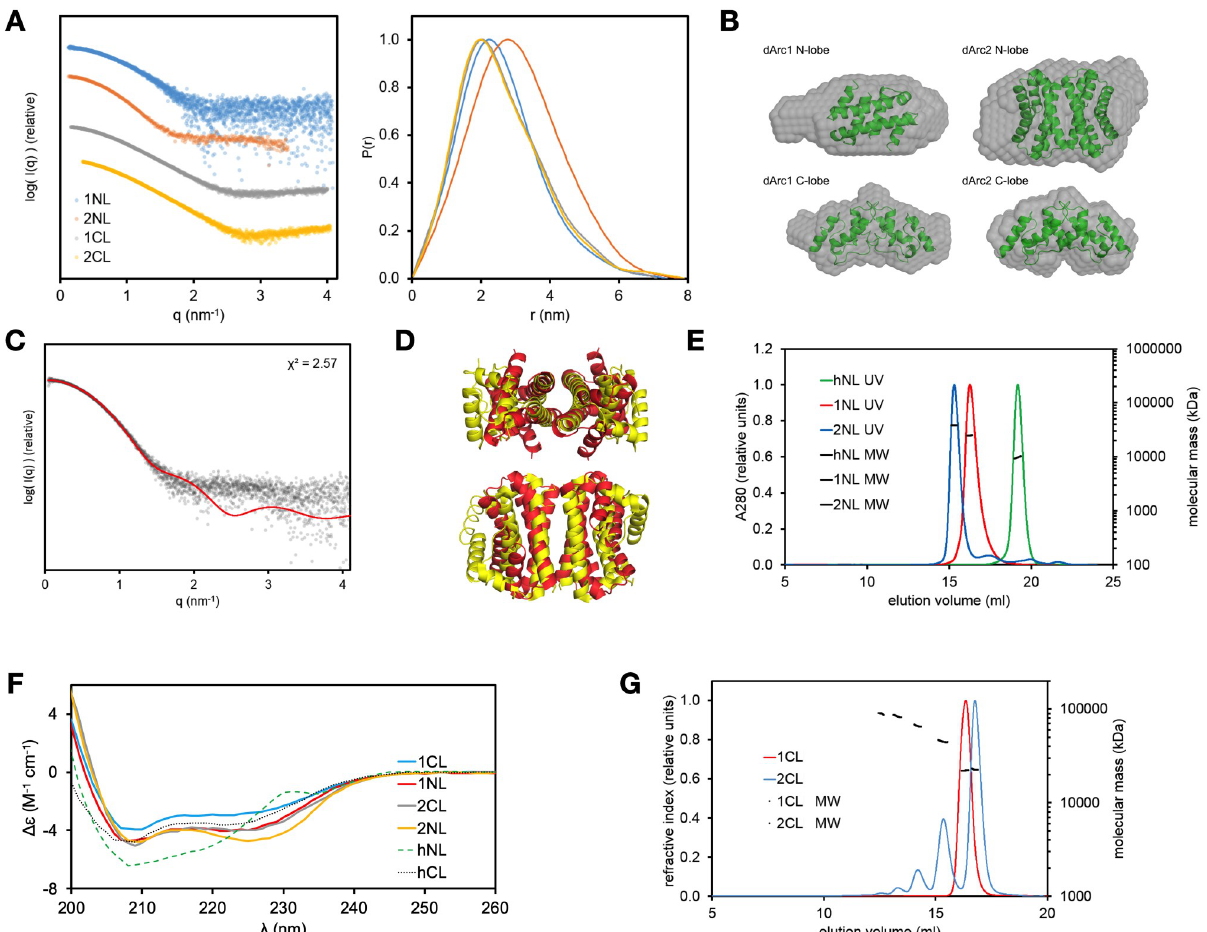
Fig 9. Solution structures of dArc lobe domains. (A) SAXS data for dArc lobes in solution (left) and distance distribution plots (right). (B) Ab initio models (grey spheres) of dArc lobes. The models are superimposed with the following structures (shown as cartoons): dArc2-NL dimer (overlaid on dArc1-NL), dArc1-CL dimer (on dArc1-CL), a dimer of dArc2-NL dimers (on dArc2-NL), and dArc2-CL dimer (on dArc2-CL). (C) Fit of the SAXS data for dArc2-NL (dots) with the possible tetramer of dArc2-NL seen in panel (D). (D) Tetrameric assembly of the West Nile virus protein C (yellow) and an aligned structure of two dArc2-NL dimers (red) showing a possible tetrameric structure. (E) SEC-MALS for human and Drosophila N-lobes. (F) CD data for dArc and hArc lobes. (G) SEC-MALS for human and Drosophila C-lobes.